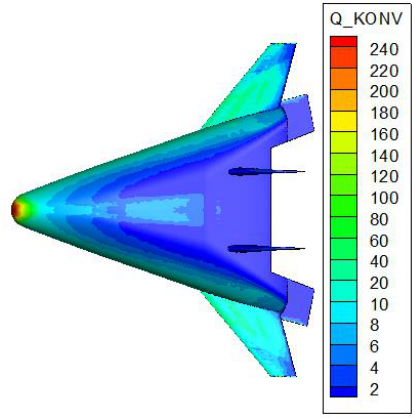
Figure 1. Convective heat distribution q w (kW/m 2 ) for X-33 upper part, Mach number M = 6, height Figure 1. C onvective heat distribution (kW/m 2 ) for X-33 upper part, Mach number M = 6, height w q H = 25 km, attack angle α = 10 ◦ . H = 25 km, attack angle  = 10°.